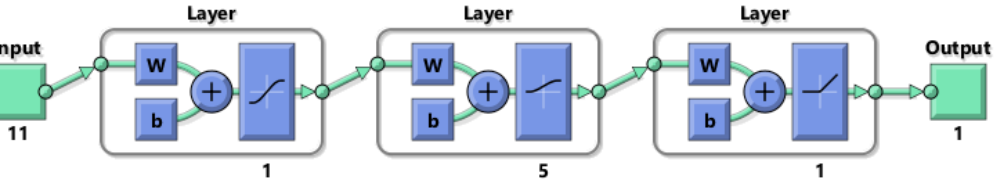
Figure 16. Inverse model network -